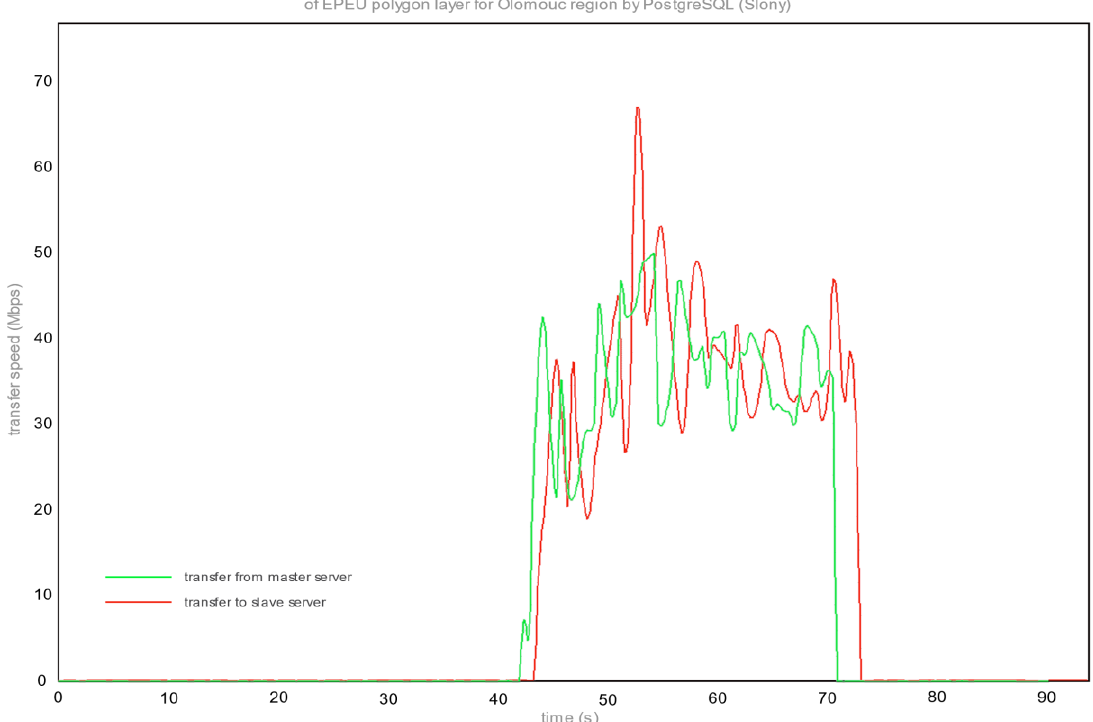
Figure 5. Replication transfer speed of the EPEU layer by PostgreSQL (Slony).